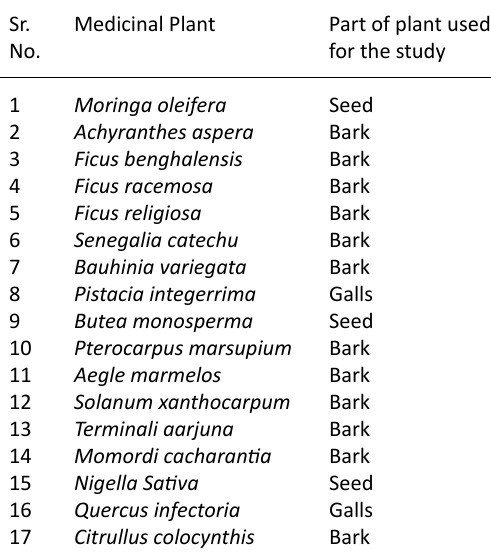
Table 1. Medicinal plants used for the study